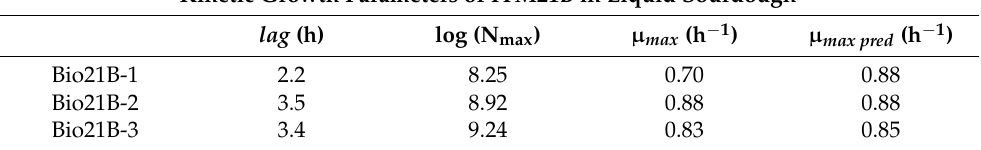
Table 3. Predicted kinetic parameters determined in liquid sourdough Bio21B-1, Bio21B-2, and Bio21B-3 using the model parameters for L. plantarum ITM21B and Equation (4). Kinetic Growth Parameters of ITM21B in Liquid